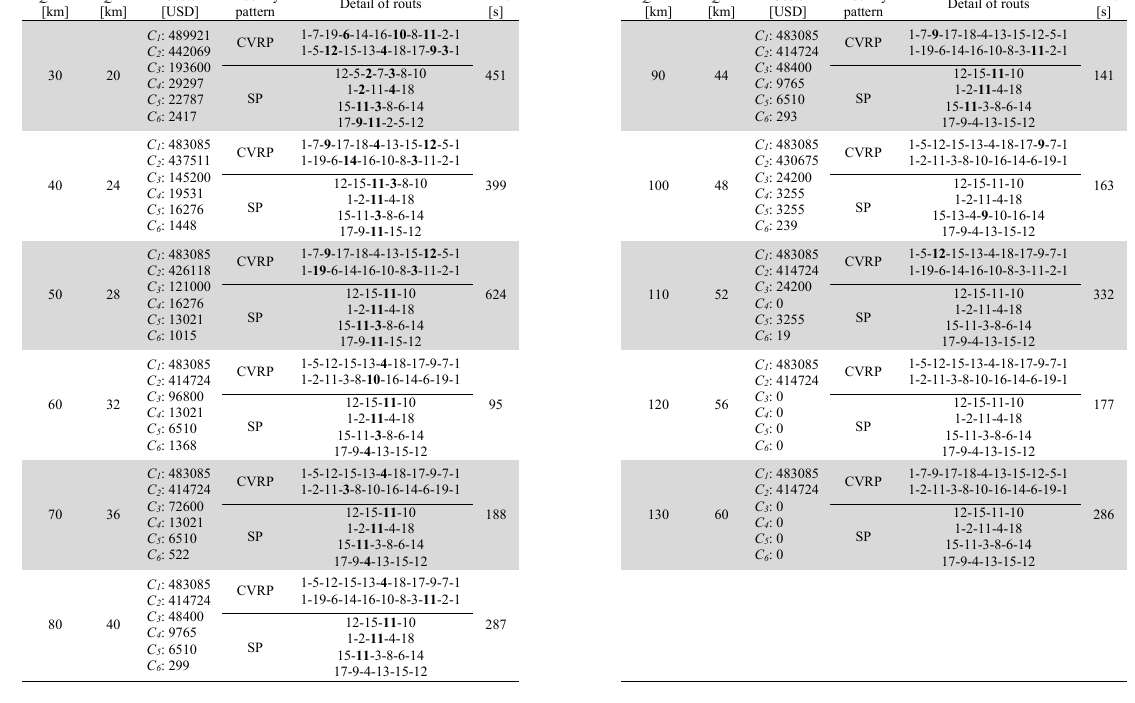
Results for Pn19k2-IEEE34 with linearized mathematical model Q